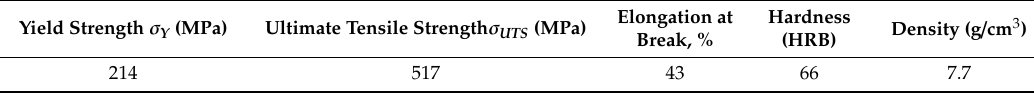
Table 2. Mechanical properties of AISI 316L steel studied by Nastac et al.